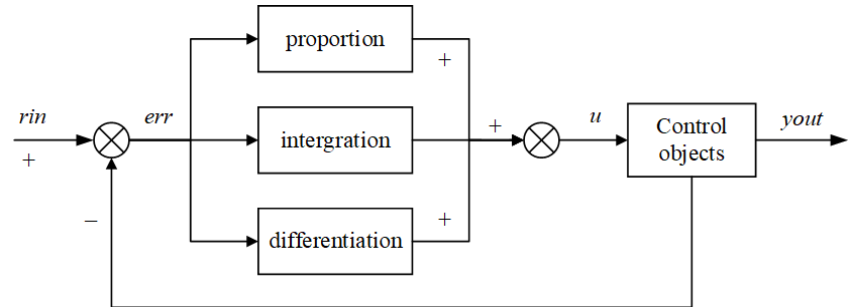
Figure 3. PID control schematic.